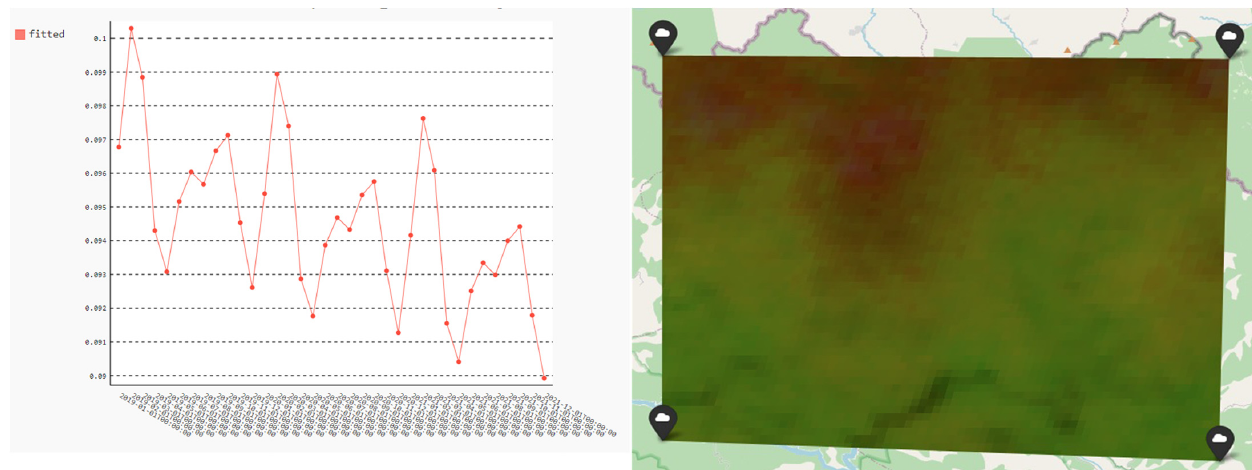
Figure 6. Harmonized mean NDVI values.